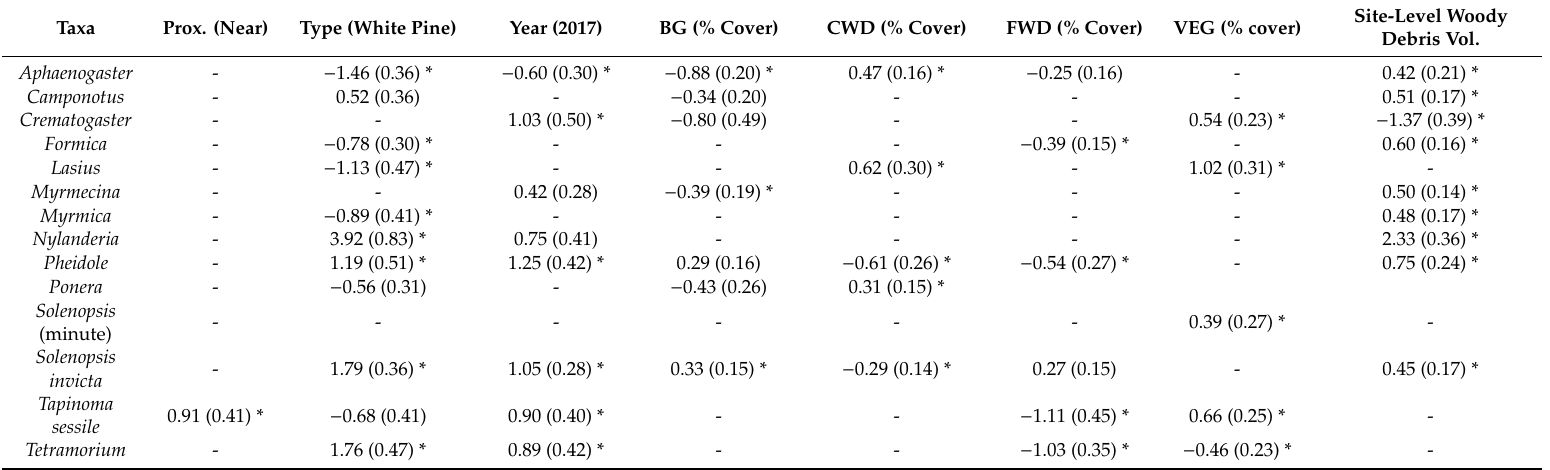
Table 5. Coe ffi cients for the relationship between probability of capture of each ant genus / species and the habitat covariates included in the most competitive logistic regression model based on captures at 10 harvested locations in western North Carolina USA (2016–2017). Standard errors are noted in parentheses. BG stands for Bare Ground and VEG stands for Vegetation. A “ − ” means that the specific variable was not included in the top model for the taxa. * Indicates p -value <